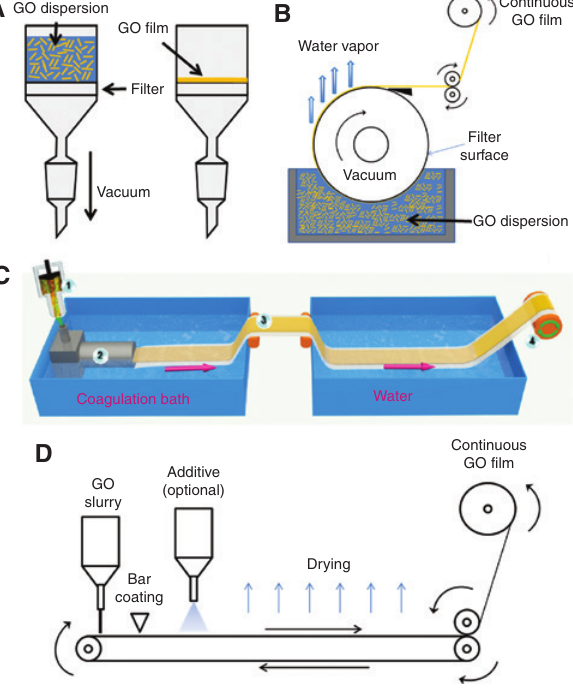
Figure 1: Schematic diagrams depicting the methods for preparing GO films. (A) Vacuum filtration (batch), (B) continuous vacuum filtration or casting, (C) continuous slit-die wet spinning [23], and (D) continuous blade coating